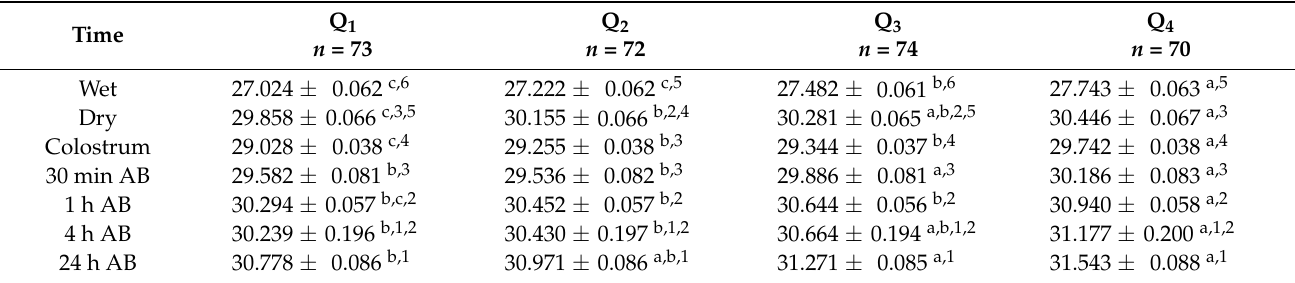
Table 3. Average of the temperature of thoracic limb metacarpal (TLM) window at different times in newborn puppies classified into 4 groups according to weight.